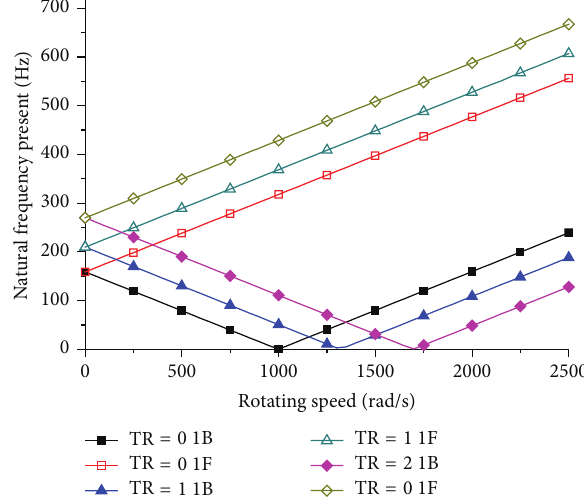
Figure 11: Campbell diagrams of the shaft with 𝜃 = 0 ∘